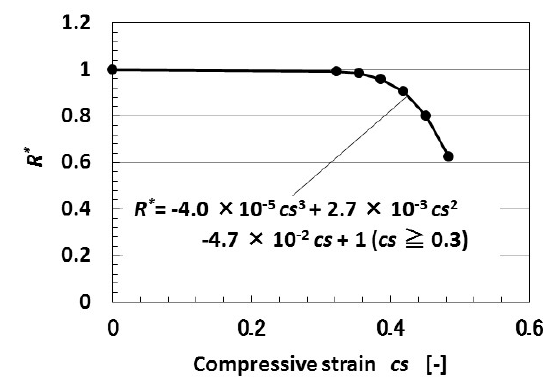
Figure 3. Theoretical results of dimensionless resistance to compression by tunneling theory.